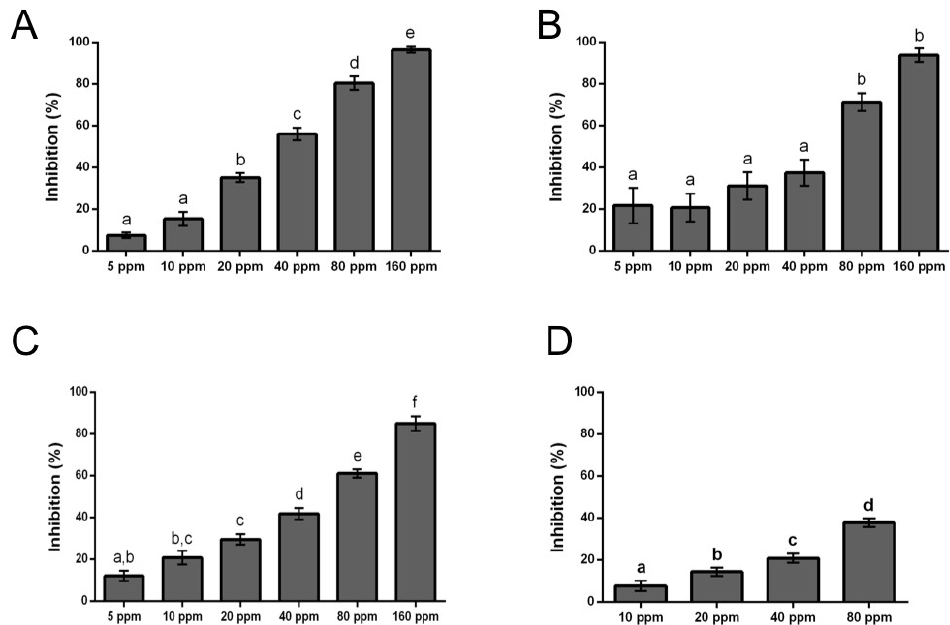
Figure 5. Effect of eugenol derivatives on mycelial growth of Botrytis cinerea in solid media. Percentage of inhibition of mycelial growth determined after 48 h of incubation at different concentrations: ( A ) 14 , ( B ) 15 , ( C ) 11 , ( D ) BC-1000 commercial compound used as control. Each bar represents the average of at least three independent experiments ± standard deviation. ( a – f ) indicates significant differences between each compound concentration, evaluated by Tukey’s test; p < 0.05.